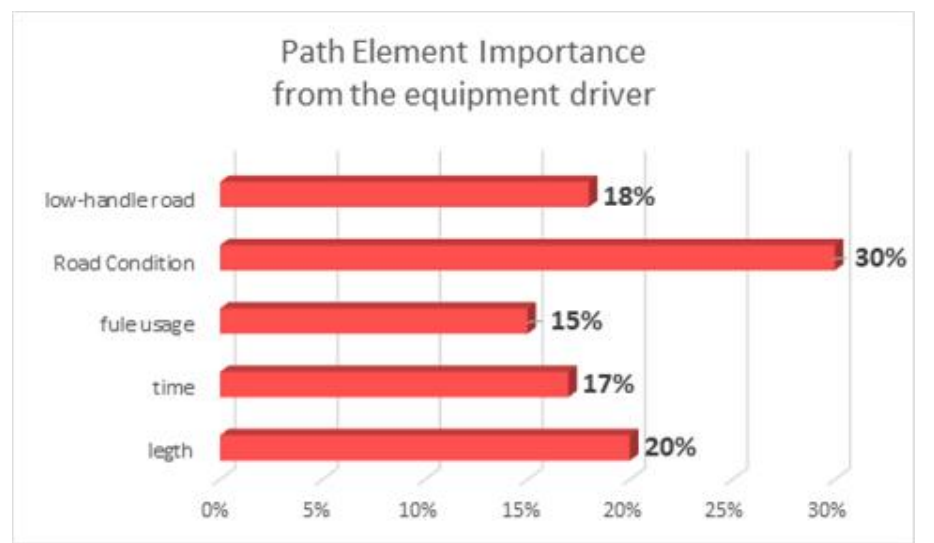
Figure 3. Path element importance from the equipment driver.